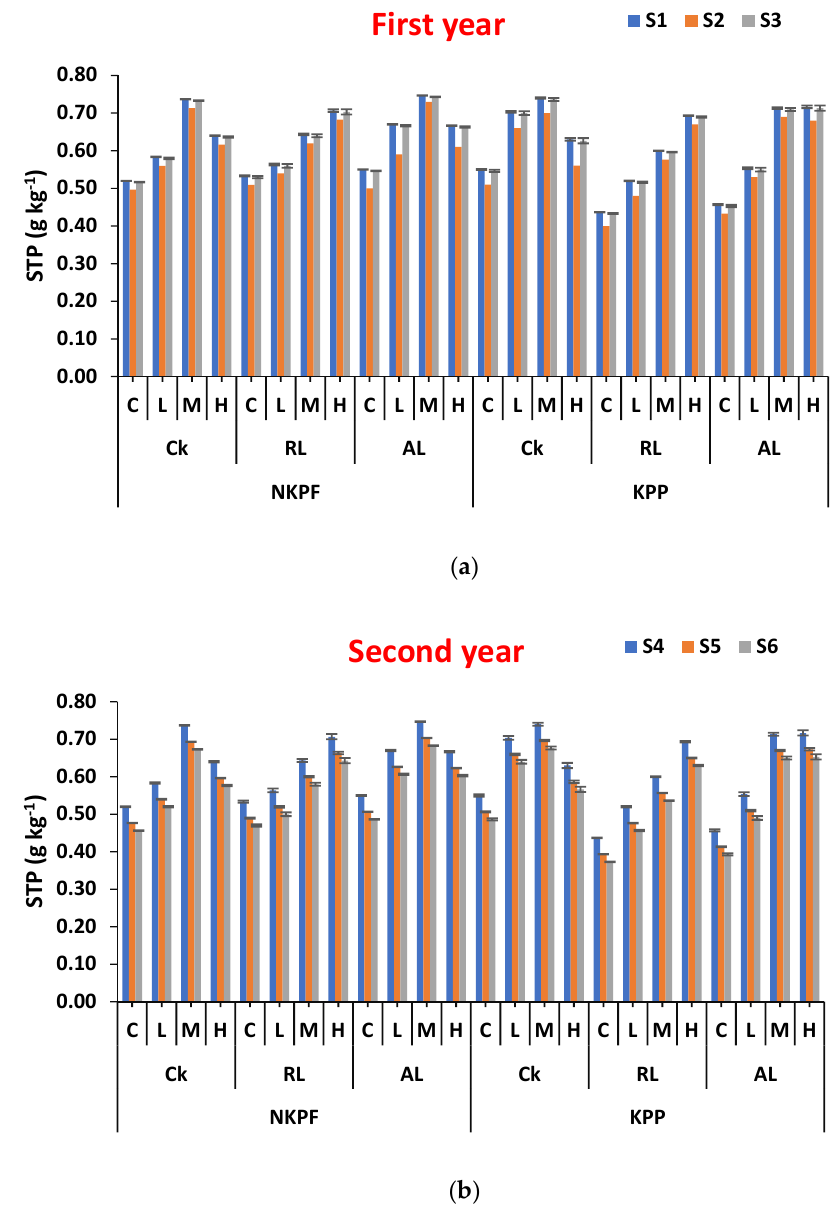
Figure 2. Changes in STP during ( a ) first year and ( b ) second year of experiment affected by different litter treatments at various N and P levels under two forest types. Table 4. Increase/decrease in SOC, C:N, STN and STP at the end of experiment as compared to initial stages.